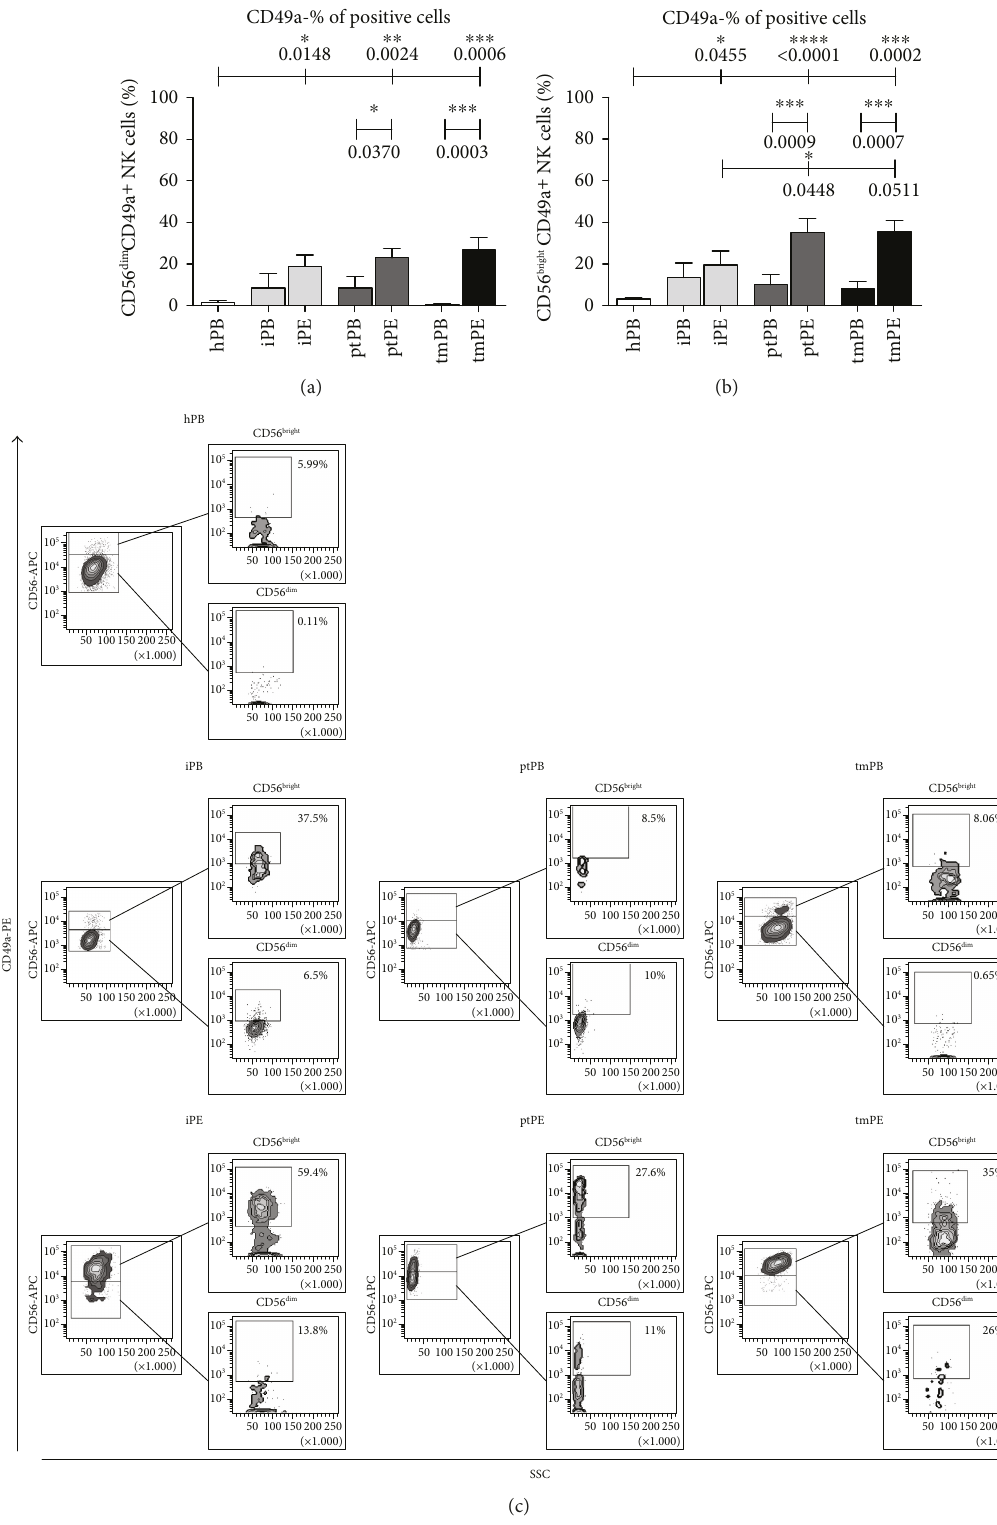
Figure 2: CD49-decidual marker expression on NK cell subsets. Flow cytometric analysis demonstrated that in NK cells from patients with pleural e ff usions, CD49a expression was increased in the CD56 bright subset from pleural e ff usion (signi fi cantly in ptPE and in tmPE) as compared to PB-NK cell samples (a, b). Representative dot plots for CD49a expression on CD56 bright and CD56 dim NK subsets in healthy donors and patients with in fl ammatory, primary, and metastatic tumor PE are shown, respectively (c). Data are shown as mean ± SEM of 39 samples; ∗ p < 0 05 , ∗∗ p < 0 01 , ∗∗∗ p < 0 001 , and ∗∗∗∗ p < 0 0001 ( p values are